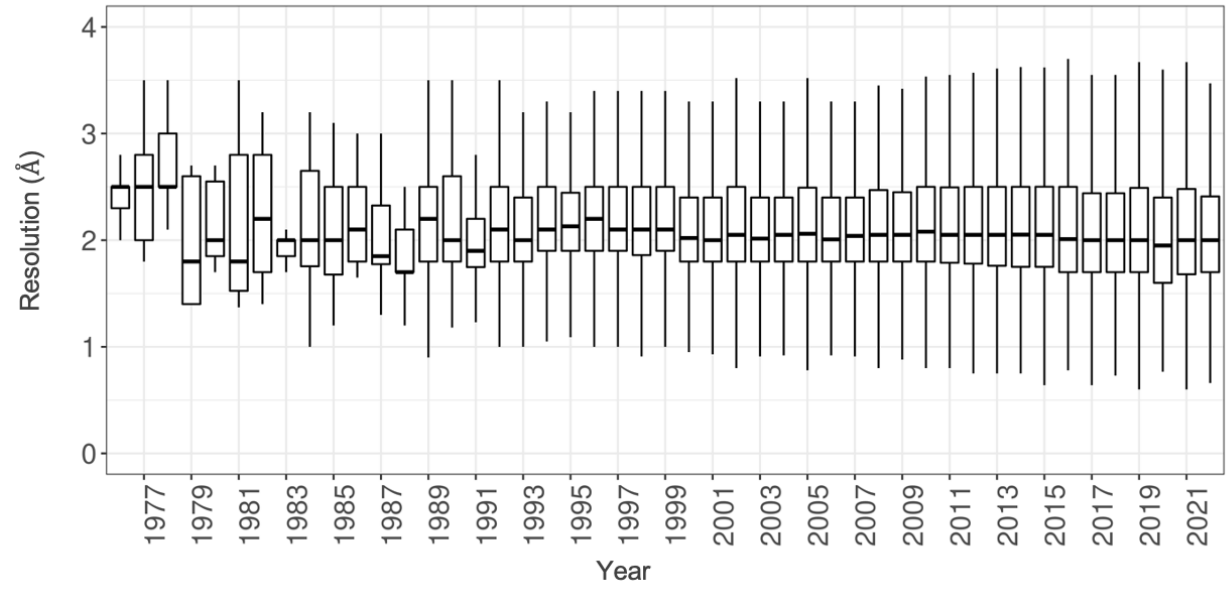
Figure 4. Box plot display of PDB MX structure resolution vs. time. The bold solid bar within each box corresponds to the median value for structures publicly released that year. (N.B.: Small numbers of extreme outliers with resolution > 4 Å were excluded from this analysis for clarity).